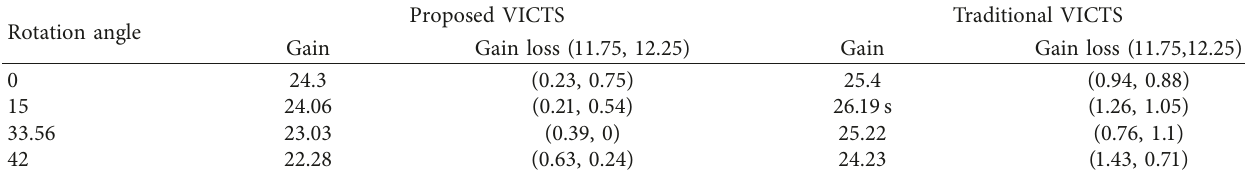
Table 2: Gain at 12GHz and gain loss at 11.75 and 12.25 GHz compared with the traditional VICTS antenna. Proposed VICTS Traditional VICTS Rotation angle Gain loss (11.75,